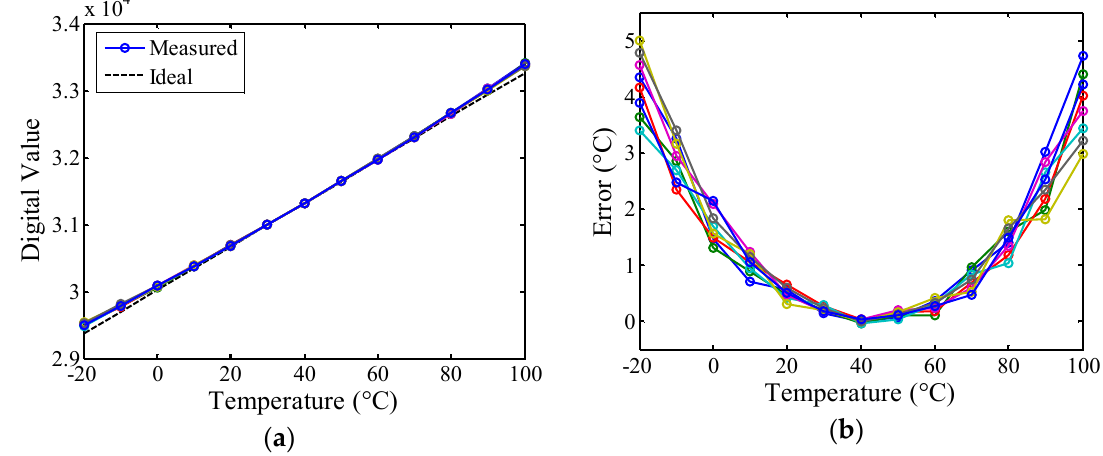
Figure 13. ( a ) Measured transfer curves of the N(T) for eight FPGA chips after calibration and ideal curve for comparison; ( b ) Inaccuracies of the calibrated (unlinearized) sensor after one-point calibration.